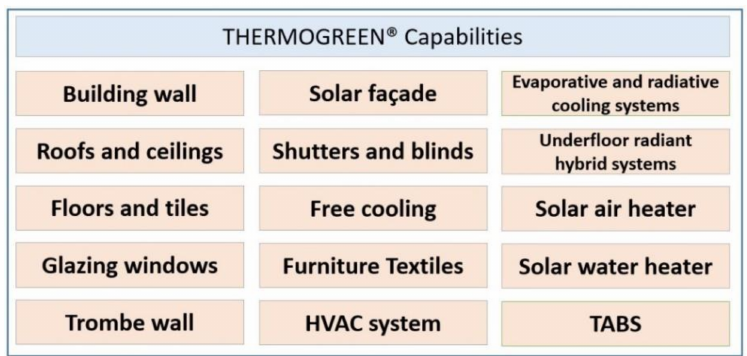
Figure 23. Capabilities of the proposed